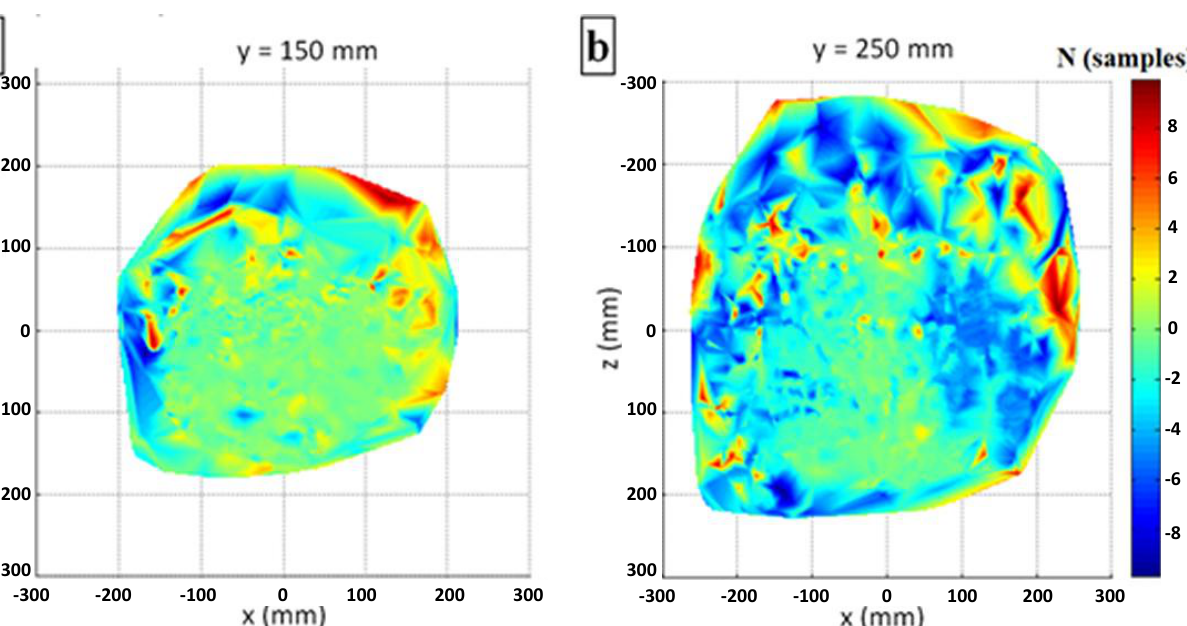
Figure 11. Distance deviation distributions in x - z plane at ( a ) y = 150 mm; and ( b ) y = 250